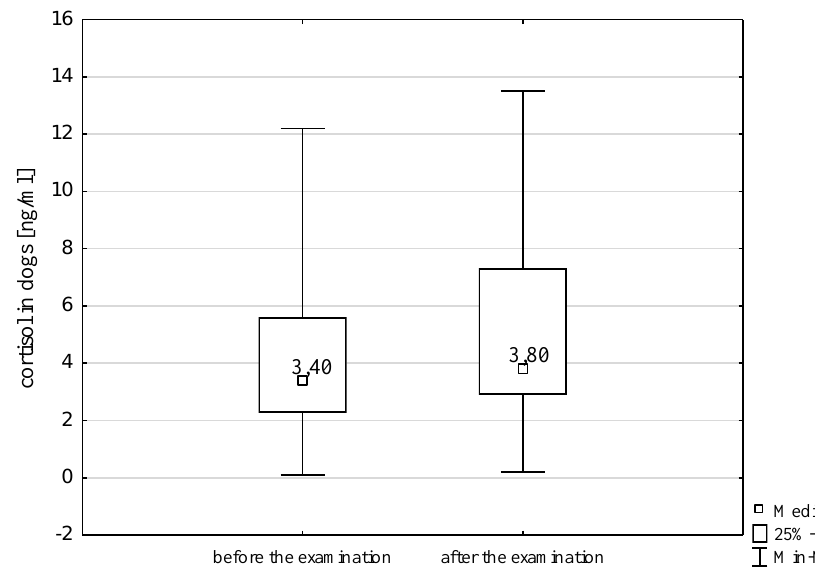
Figure 2. Box plot of the cortisol level in the dogs before and after the examination.